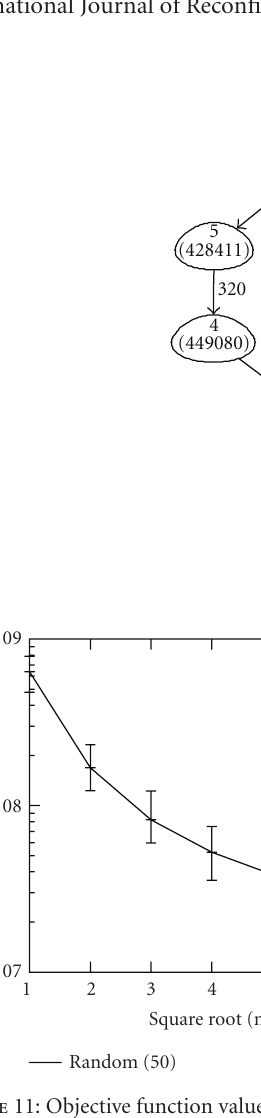
Figure 11: Objective function value space for 50 tasks and random mapping.